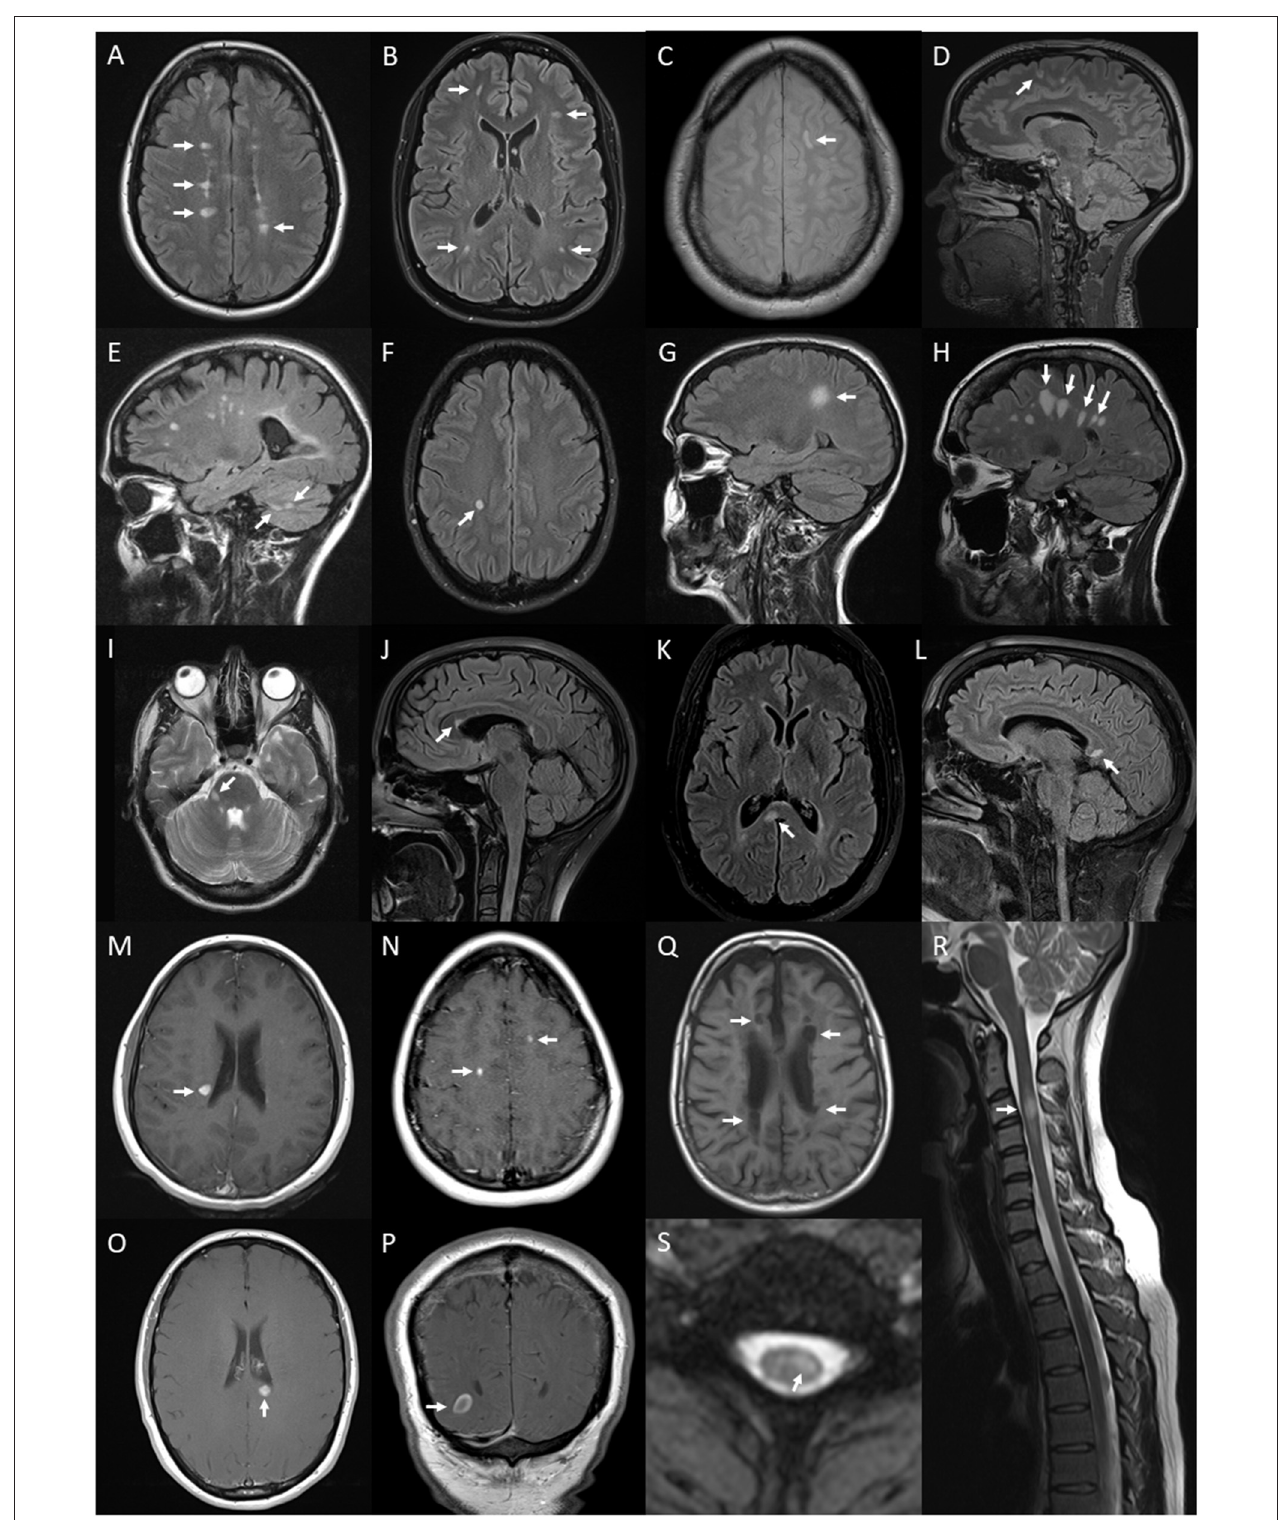
FIGURE 6 | Lesions and features on MRI of brain and spinal cord associated with multiple sclerosis: periventricular hyperintense T2 white matter lesions (arrows) on axial FLAIR image of the brain (A) ; subcortical T2 white matter lesions (arrows) on axial FLAIR image of the brain (B) ; juxtacortical hyperintense T2 white matter lesion (arrow) on axial proton density image of the brain (C) ; cortical hyperintense T2 lesion (arrow) on sagittal FLAIR image of the brain (D) ; cerebellar hyperintense T2